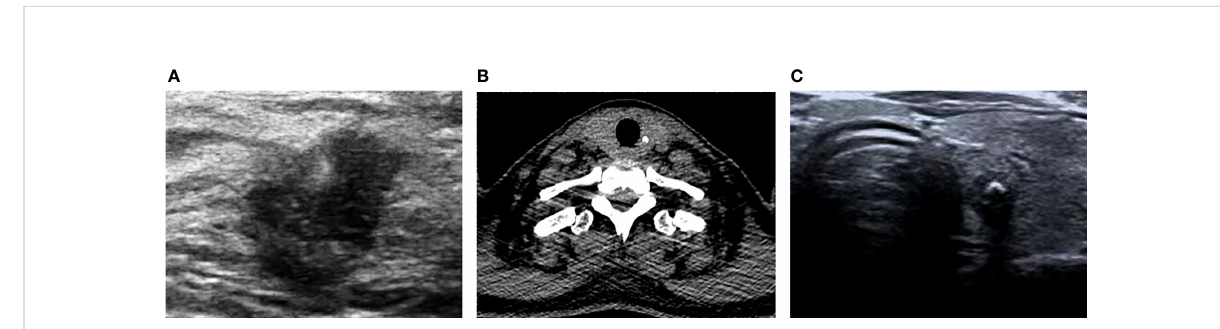
FIGURE 1 The Doppler ultrasound test of the breast and axilla demonstrated a large, 1.85 × 1.12 × 1.54 cm retro-areolar lump at the 8 o ’ clock position (A) . The CT scan of the thyroid presented a 4-mm calcium lesion in the left lobular (B) . The Doppler ultrasound test of the thyroid gland showed a large, 0.65 × 0.58 × 0.65 cm TI-RADS 4a solid nodule with calci fi cation found in the middle-upper part of the left lobular (C)